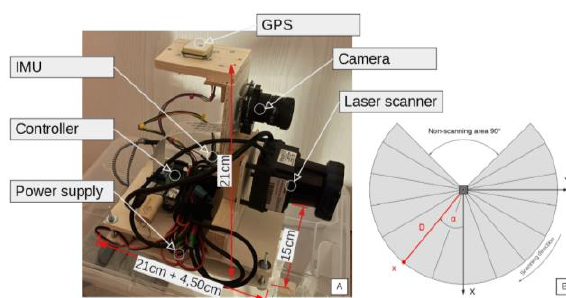
Figure 3 . (A) Developed test platform and (B) schematic representation of the scan